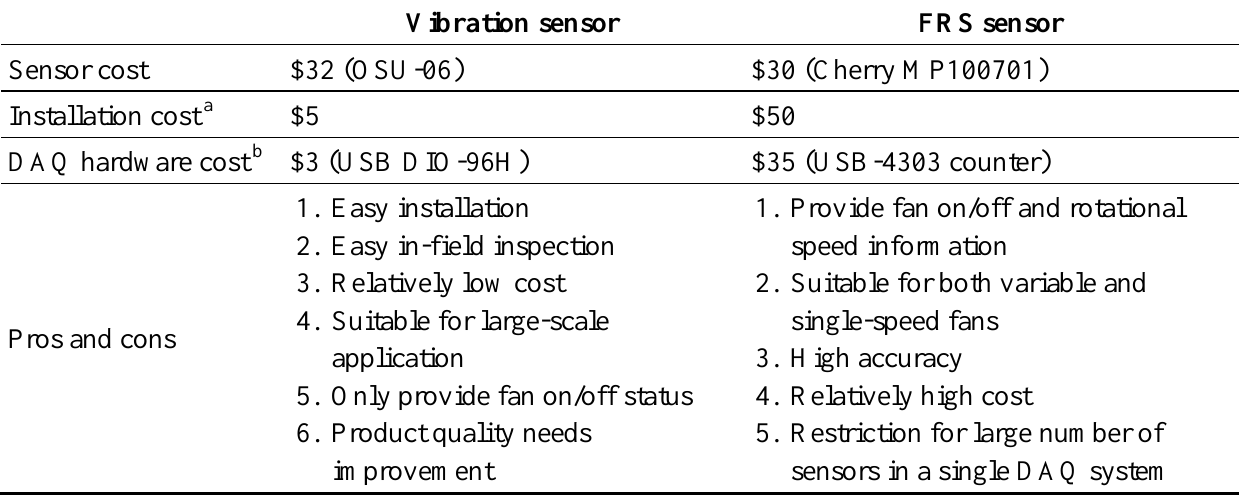
Table 4. Comparison of the vibration sensor with the magnetic proximity FRS